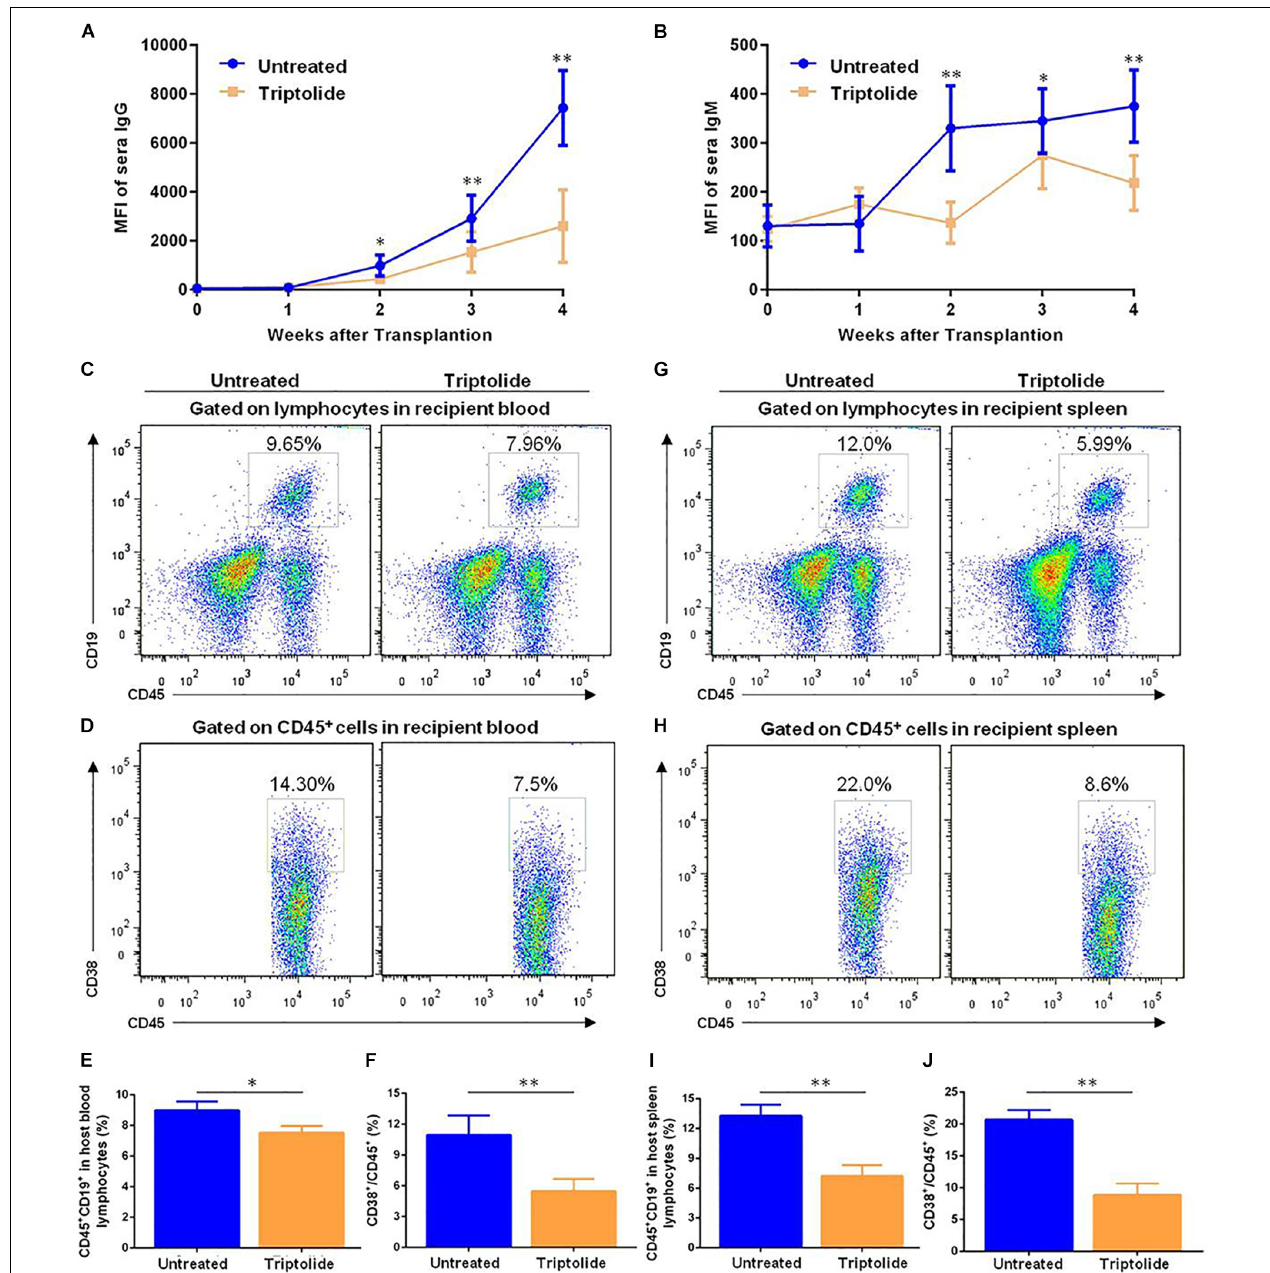
FIGURE 6 | Triptolide decreases the production of donor-specific antibodies (DSA) and reduces the amounts of B cells and plasma cells in vivo . Transplant-recipient sera collected at the indicated time points were reacted with donor spleen cells and evaluated for antibody production by flow cytometry. Circulating levels of (A) IgG and (B) IgM are expressed as mean fluorescence intensity ± SD ( n = 5). B cells (CD45 + , CD19 + ) and plasma cells (CD45 + , CD38 + ) were detected by flow cytometry in recipient blood and spleen 4 weeks after transplantation. Representative dot plots for frequencies and counts of B cells and plasma cells in recipient blood (C–F) and spleen (G–J) were shown. Data were represented as mean ± SD of at least three independent samples. ∗ p < 0.05; ∗∗ p < 0.01, Student’s t